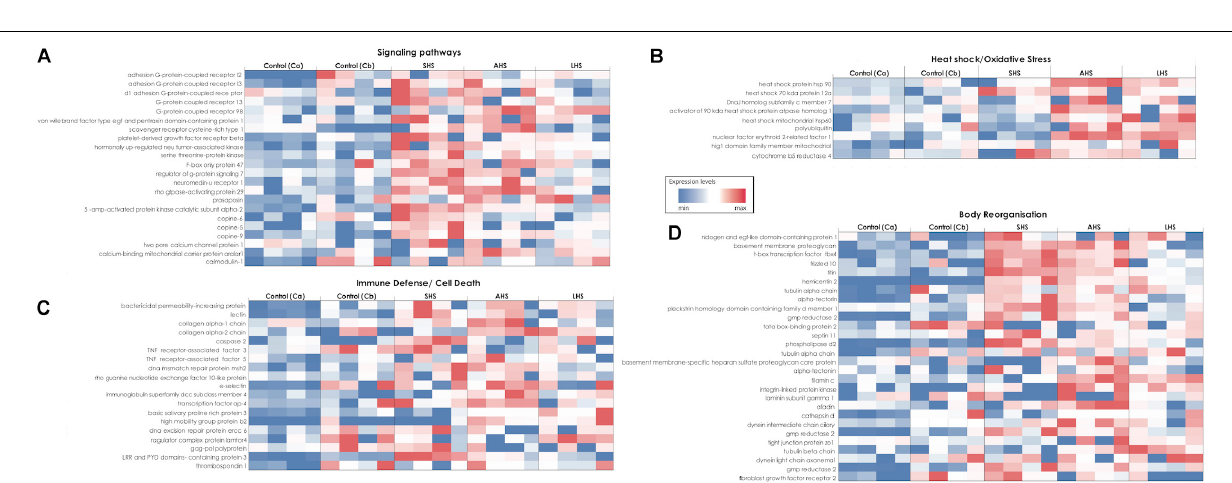
Frontiers in Marine Science |